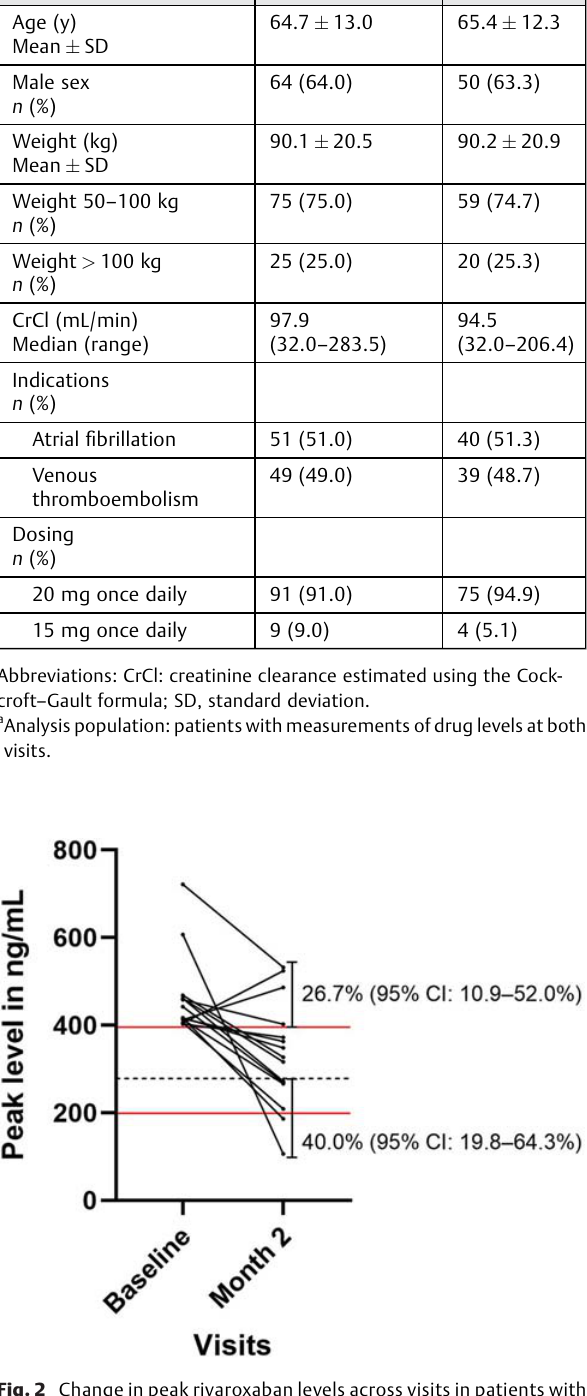
Fig. 2 Change in peak rivaroxaban levels across visits in patients with levelsfallinginthe upper20th percentiles at baseline ( (cid:4) 395.8ng/mL). Solid, red horizontal lines represent the 20th and 80th percentiles of peak levels observed at baseline. Dashed, black horizontal lines represent the median peak level at baseline (278.0 ng/mL). Propor- tions of patients with levels remaining above or below the extreme 20th percentiles at month 2 are shown by the respective vertical capped lines.